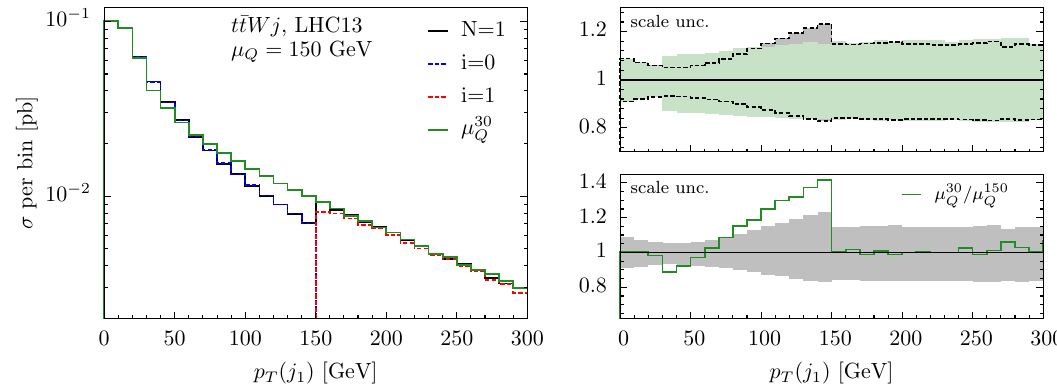
Figure 2 . Transverse-momentum differential distribution of the leading jet in a t ¯ tW FxFx merged sample using µ Q = 150 GeV as merging scale (left plot). Comparison with µ Q = 30 GeV merging scale regarding the central value and the scale uncertainties (right ratio